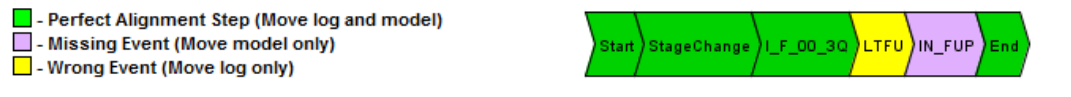
Figure 3. The most frequent trace in the complete log (I–IV) visualized via the Multi-perspective Process Explorer’s (MPE) trace view (fitness